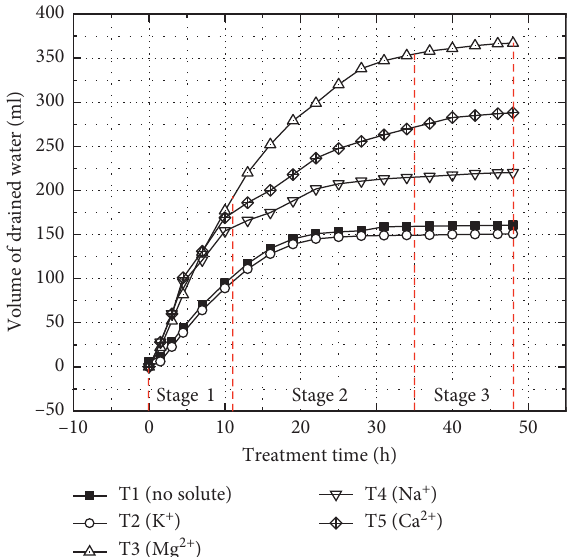
Figure 5: Effective voltage variations over treatment